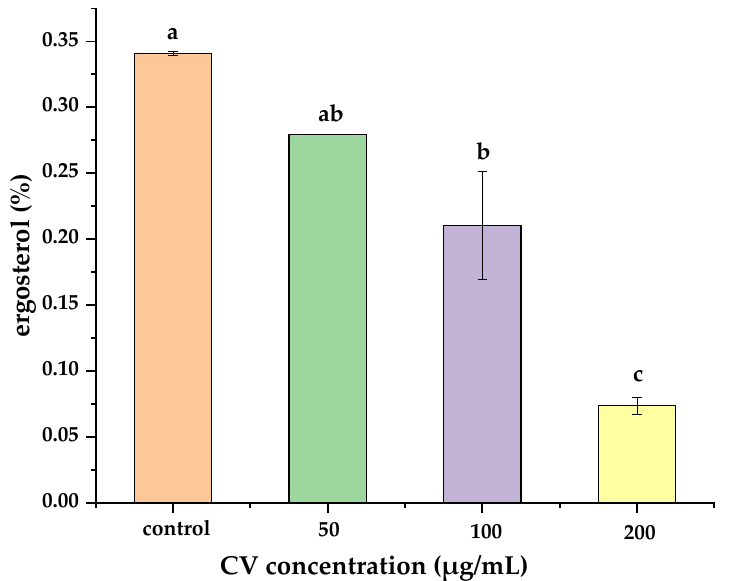
Figure 3. Ergosterol content of A. flavus mycelia. Different letters indicated significant differences ( p < 0.05).